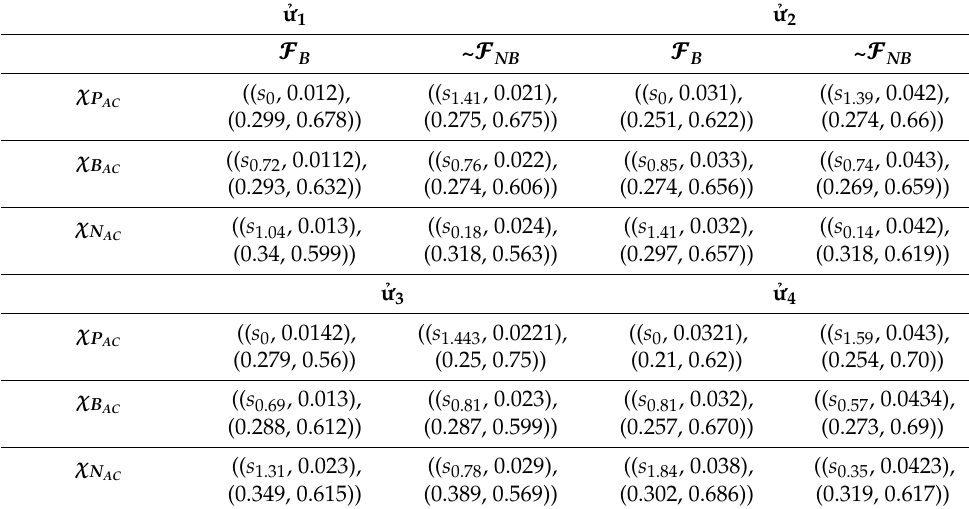
Table 5. Step 5: The final 3WD rules using Equations (41)–(43) are shown in Table 7. Step 6: The end. Table 3. Aggregated values from Tables 8–10.